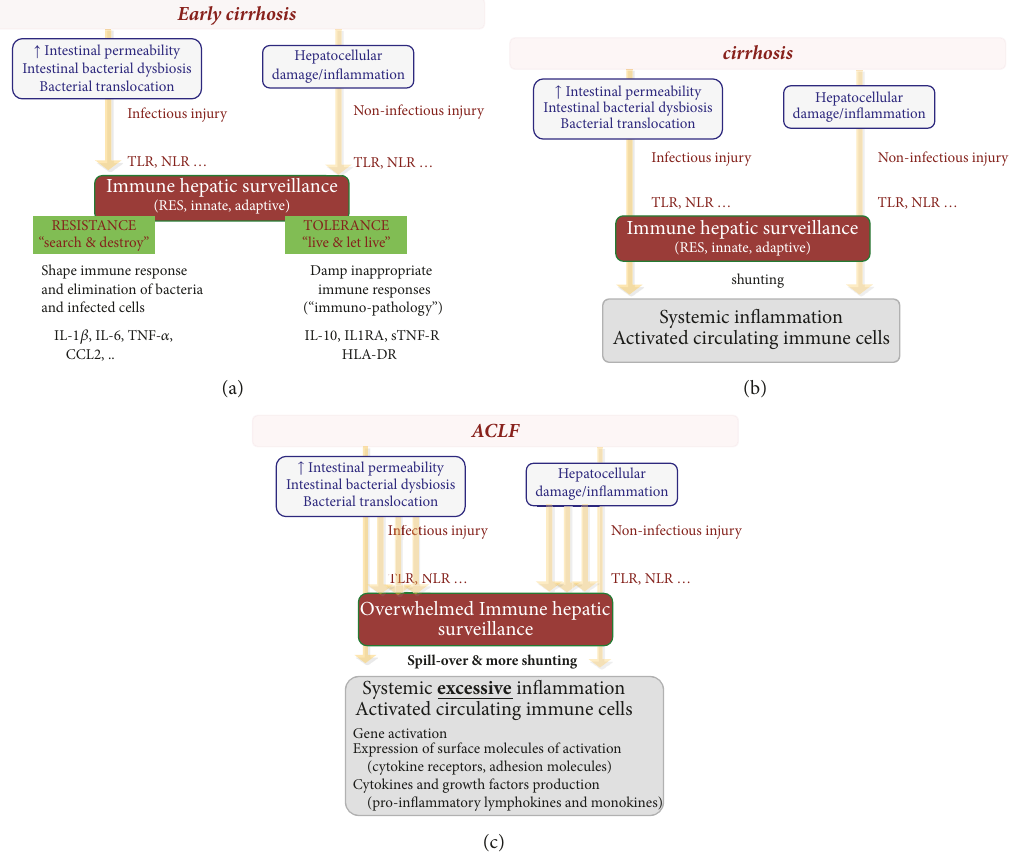
mononuclear CD14 + HLA-DR − myeloid-derived suppressor cells (M-MDSCs) who equally quell on antimicrobial defen- ces in ACLF